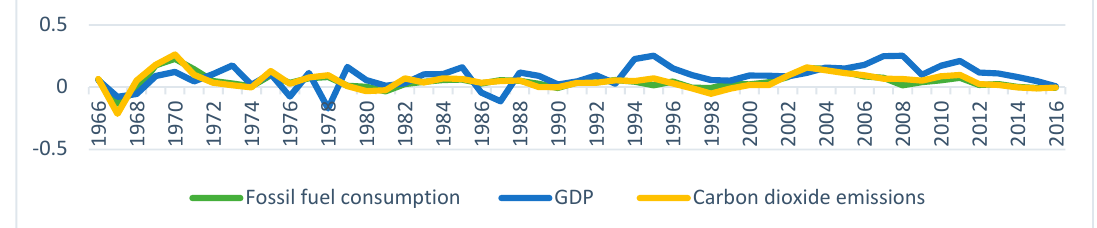
Figure 3. Time series plot for the difference in each variable (in logarithms).